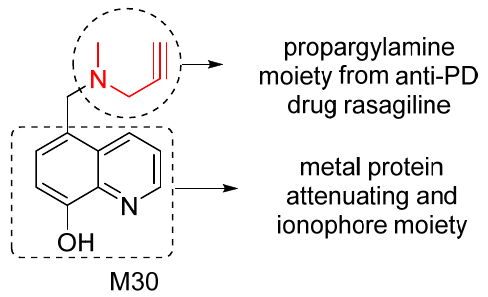
Figure 4. M30 structure and important